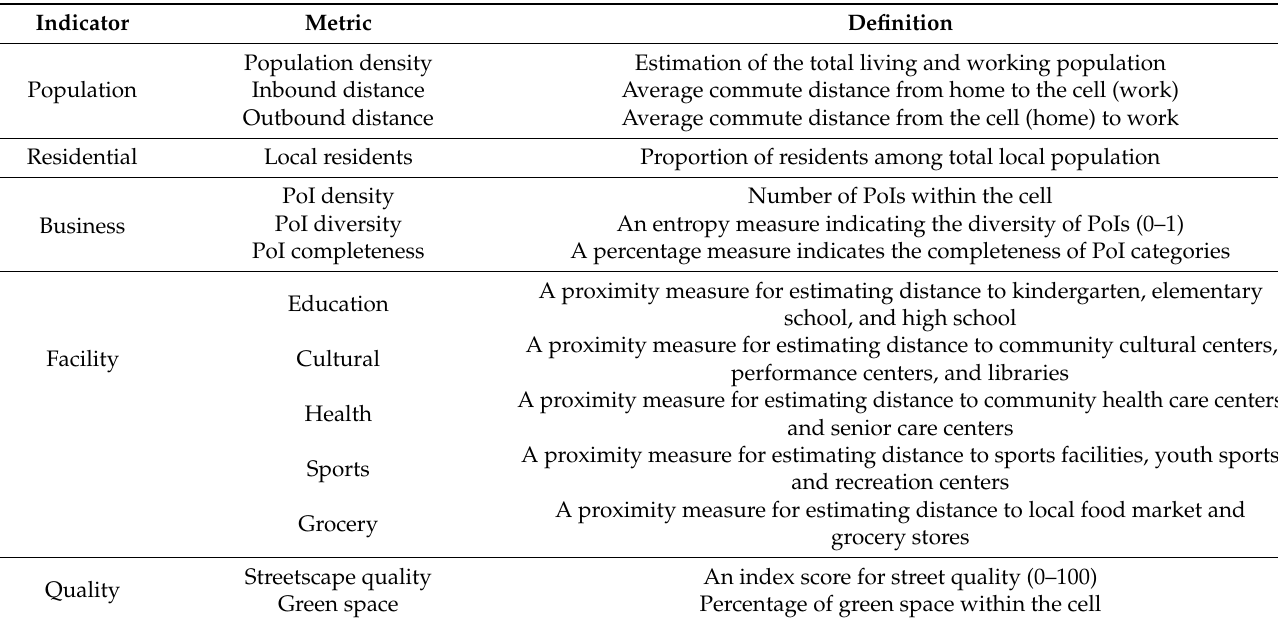
Figure 2. Visualization of extracted daily running trajectories ( n = 18,683) data within Beijing’s sixth ring road on 15 August 2022. Table 2. Neighborhood vibrancy metrics and indicators.